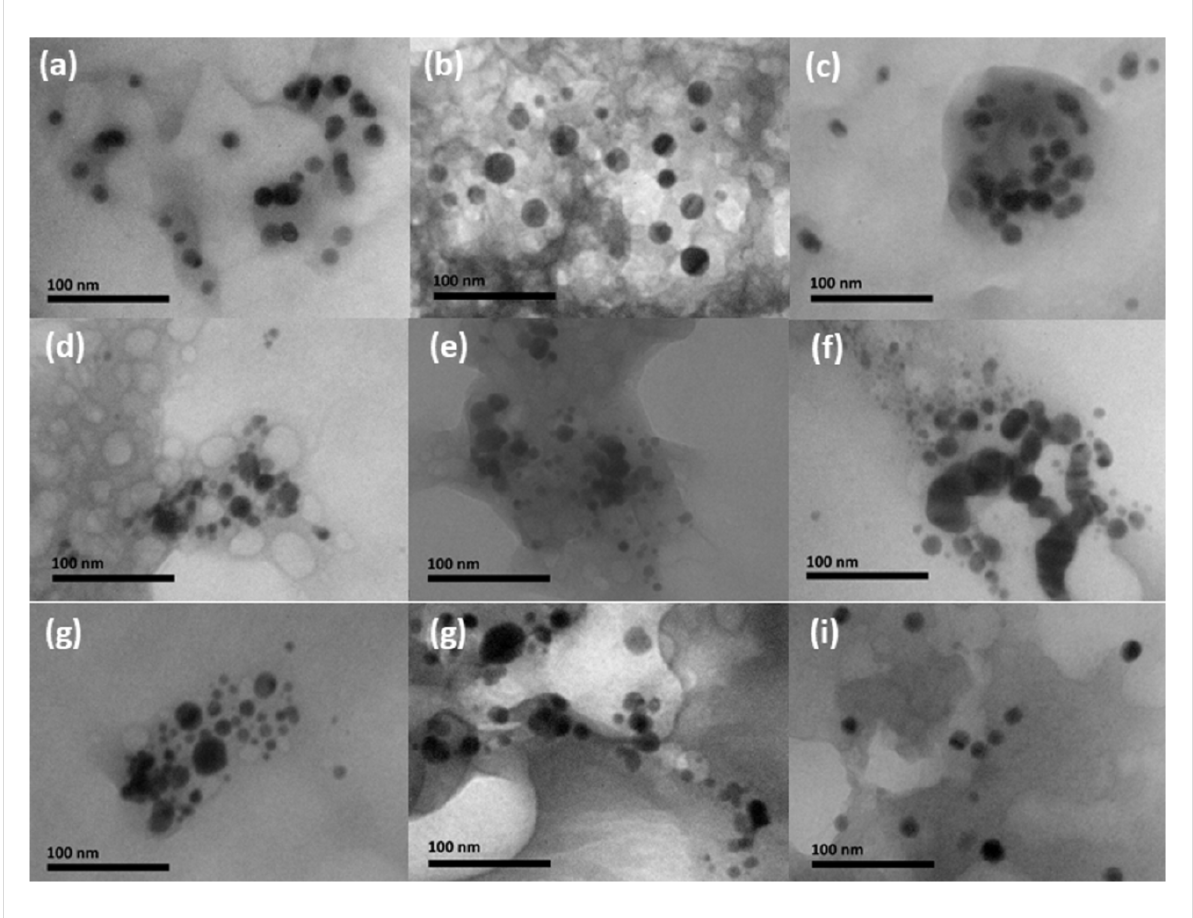
Figure 3: TEM images of differently coated AgNPs incubated for 30 min in 1% (w/v) tissue homogenates at a concentration of 100 mg Ag/L. (a) PVP- AgNPs (kidney), (b) PVP-AgNPs (liver), (c) PVP-AgNPs (brain), (d) AOT-AgNPs (kidney), (e) AOT-AgNPs (liver), (f) AOT-AgNPs (brain), (g) PLL- AgNPs (kidney), (h) PLL-AgNPs (liver), (i) PLL-AgNPs (brain). Scale bars are 100